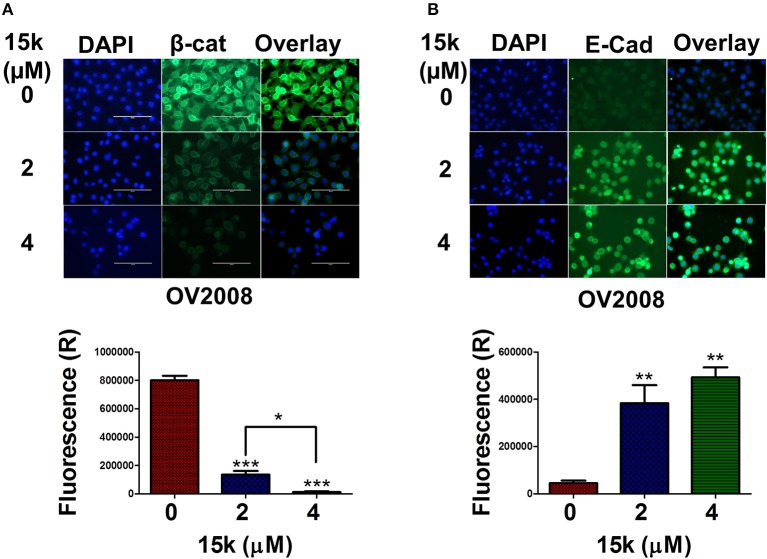
The effect of 15k on the expression levels of β-catenin (β-cat) and E-cadherin (E-Cad) in OV2008 cells using immunofluorescent staining. Cells were incubated with 15k (0, 2, and 4 μM). (A) Representative pictures of β-catenin fluorescence in OV2008 cells. (B) Representative pictures of E-cadherin fluorescence in OV2008 cells. Below each protein picture is a histogram summarizing the results where expression (R) is the relative expression. The data are presented as the means ± SEM of three independent experiments. *p < 0.05, **p < 0.01, ***p < 0.001.